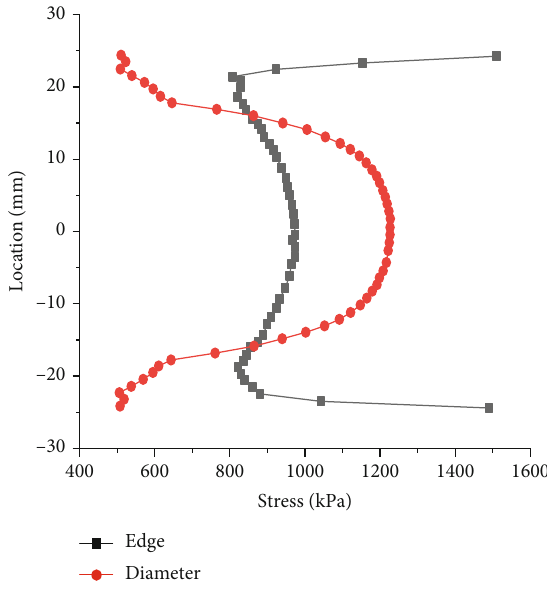
Figure 9: Equivalent stress distribution on the specimen surface (22 ° , 26 ° , and 30 °